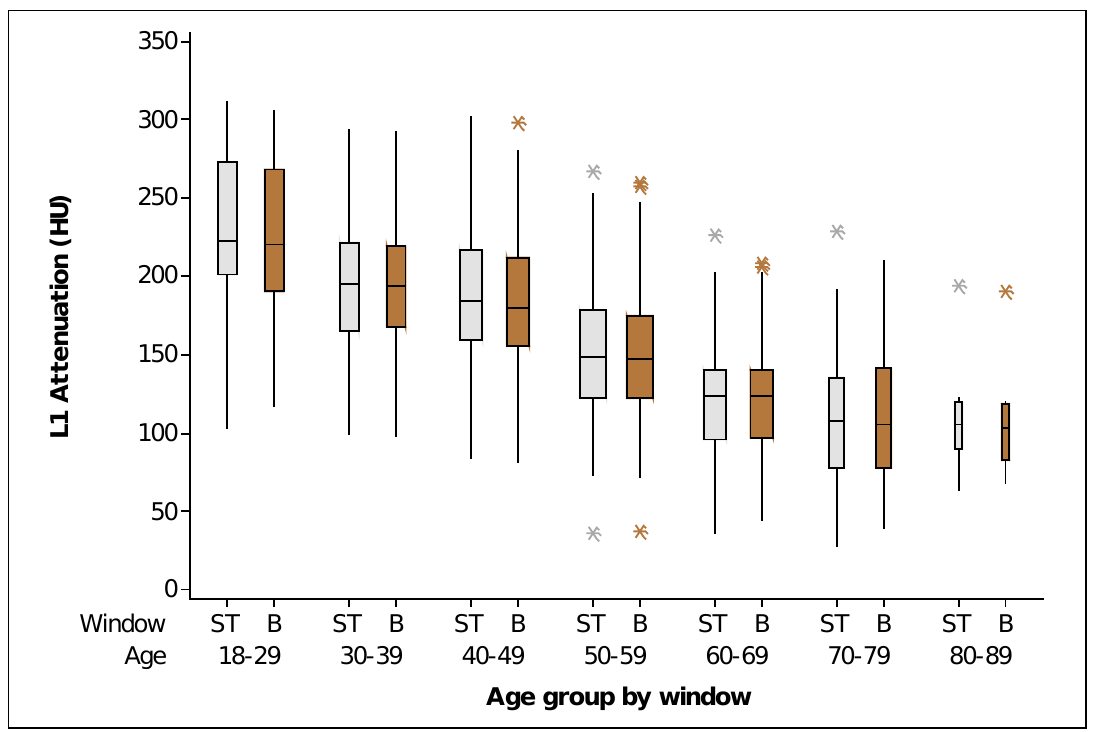
Figure 3. Box plots of the L1 trabecular attenuation (HU) measurements in the soft tissue window (ST: soft tissue; gray boxes) and bone window (B: bone; brown boxes) in the study sample ( n = 454) grouped by age (the width of the boxes is proportional to the sample size, the height of the boxes represent the distance between the first and third quartiles, the whiskers extend from either side of the boxes represent the ranges for the bottom 25% and the top 25% of the data values, and the outliers are marked with an asterisk on the boxes in each group). Table 2. L1 trabecular attenuation (HU) in both windows (soft tissue and bone) of the study sample ( n = 454) grouped by age.